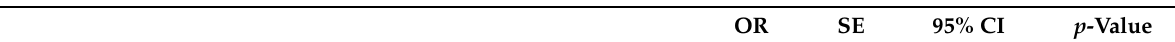
Table 2. Results of multivariate logistic regression analysis to characterize the factors associated with the different outcomes of interest.